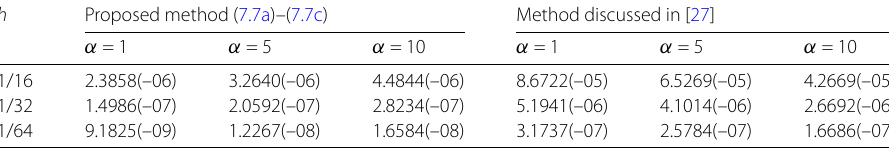
Table 10 Problem 8.10: The maximum absolute errors